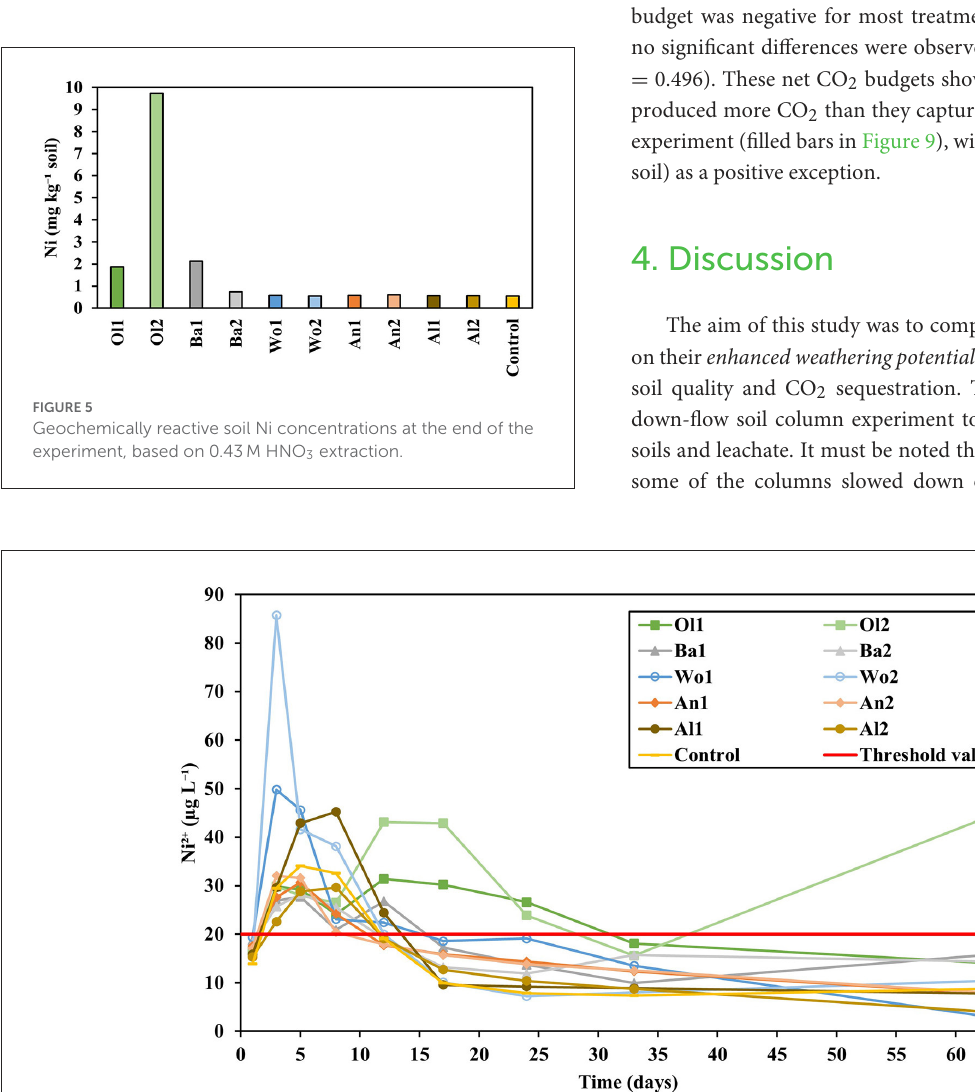
Figure 8). SOC values ranged from 18.4–17.9 g SOC kg − 1 soil